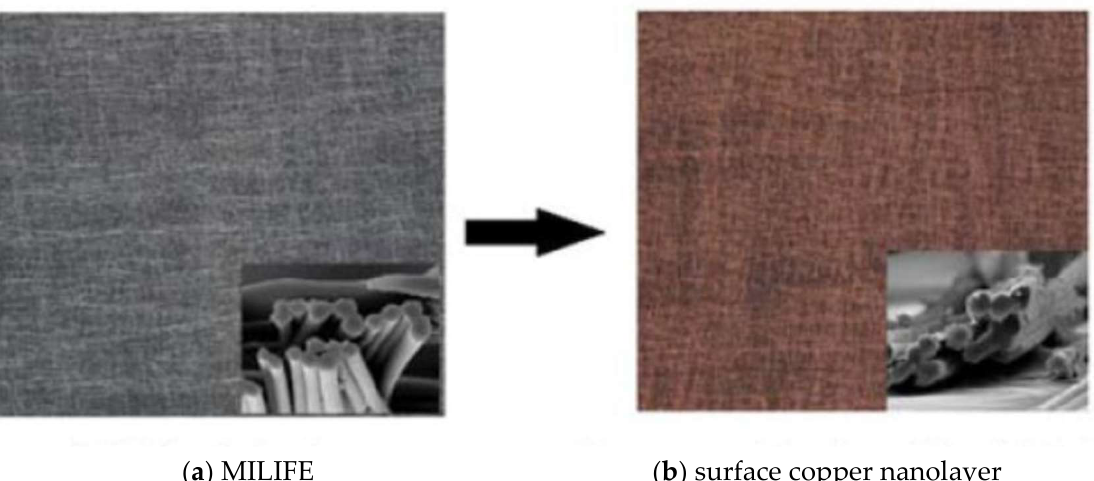
Figure 6. Composite nonwoven MILIFE with surface deposition of